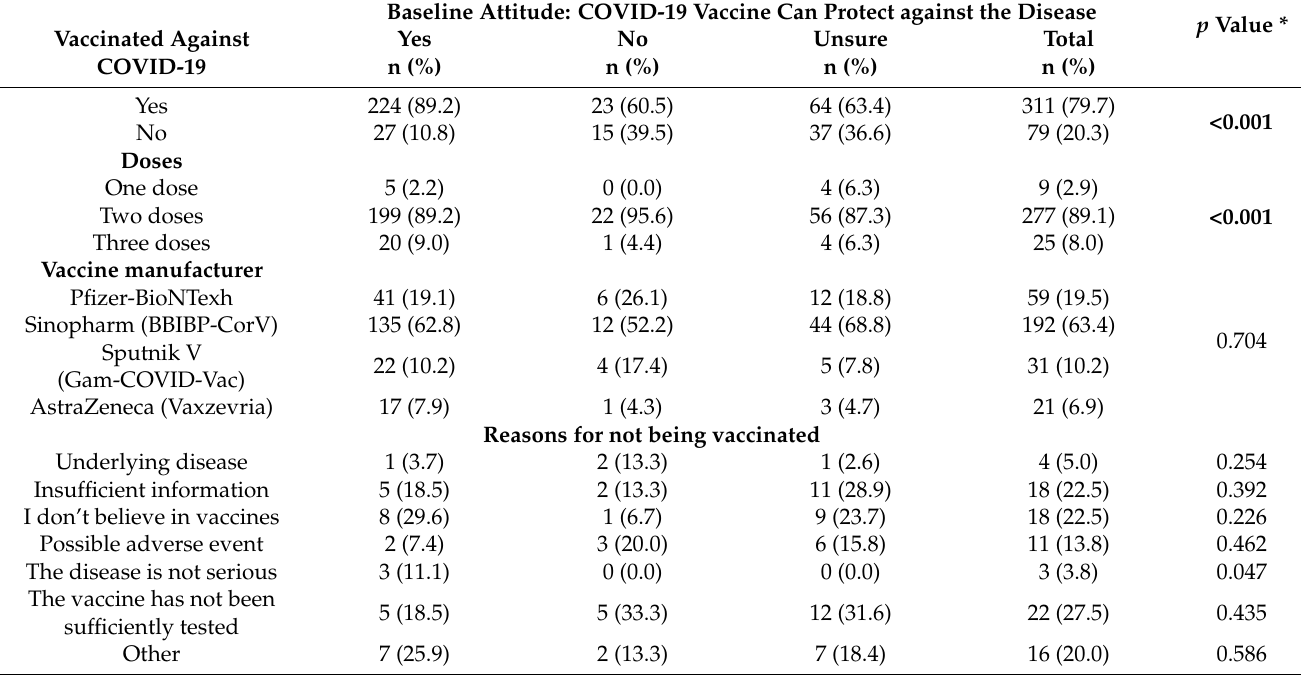
Table 3. Vaccination characteristics of participants based on baseline COVID-19 vaccine protection